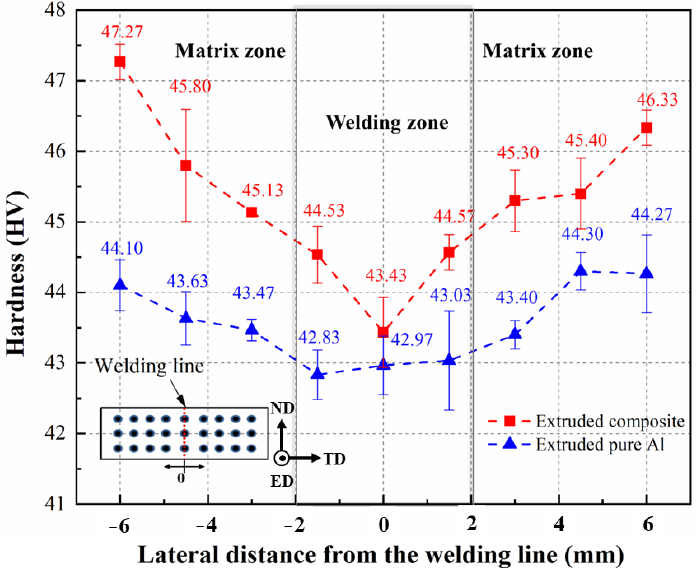
Figure 17. Microhardness on cross-sections of extruded composite and pure aluminum.